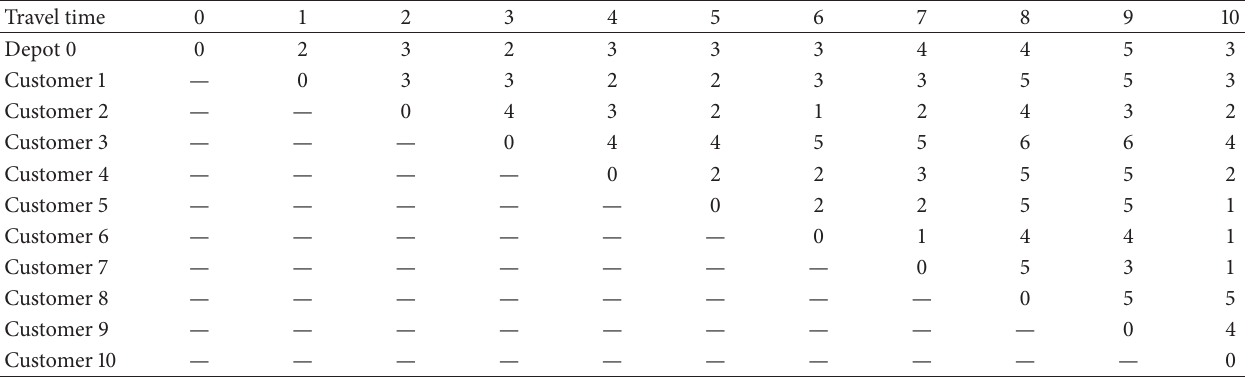
Table 2: The travel time of S logistics enterprise (day).